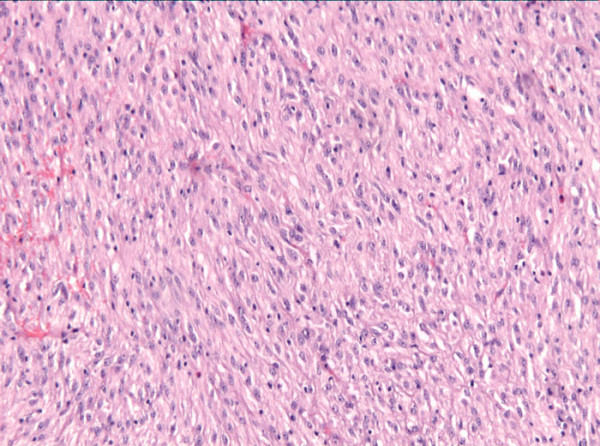
Microscopic appearance of the duodenal GIST demonstrating epithelioid and spindle cells (H&E; magnification, ×10).